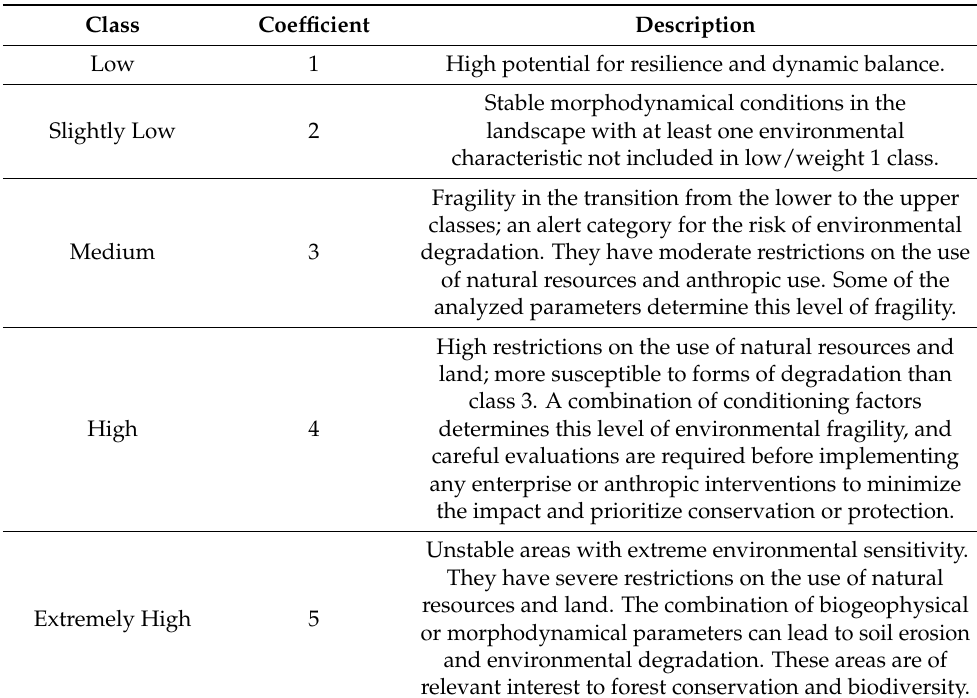
Table 2. Fragility classes and their respective weights and descriptions. Adapted from